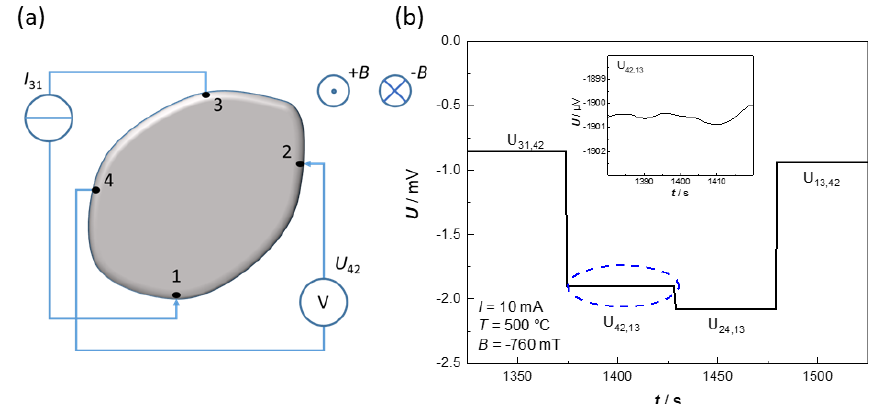
Figure 10. Measurement of the Hall coefficient. (a) Exemplary measurement configuration for the voltage U 31 , 42 . (b) Exemplary raw data of the measured voltages of a silicon wafer for the determination of the Hall coefficient at 500 ◦ C to investigate the influence of the heater.